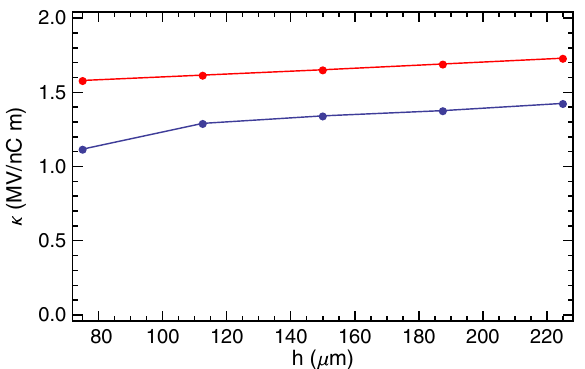
FIG. 7. The dependence of the loss factors versus h . The red color shows the theoretical values computed with Eq. (19); the blue color is simulations with KN7C